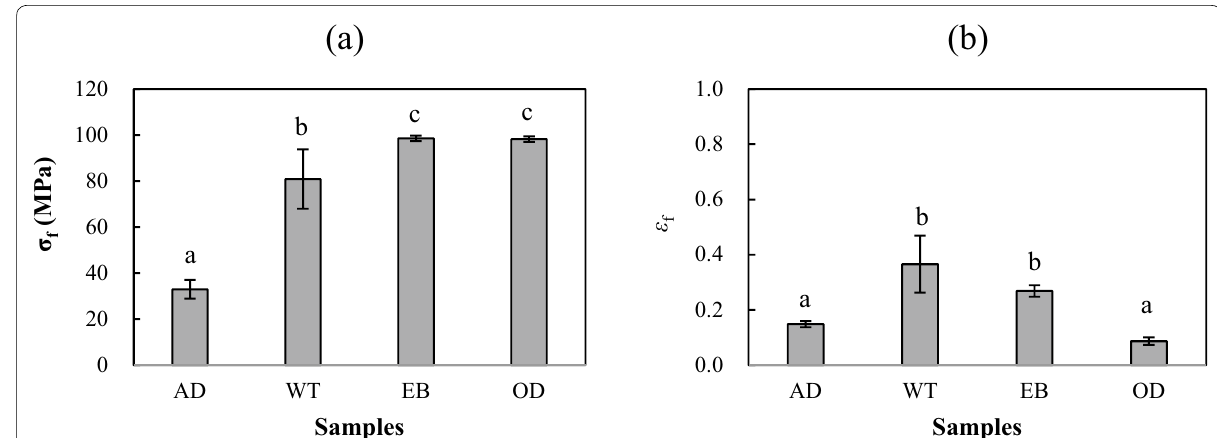
Fig. 7 Stress and strain at flow-starting point. a Compressive stress at the flow-starting point ( σ f ). b Compressive strain at the flow-starting point ( ɛ f ). Means with the same letter (a, b, c) are not significantly different (Tukey–Kramer test, p < 0.01) ( n